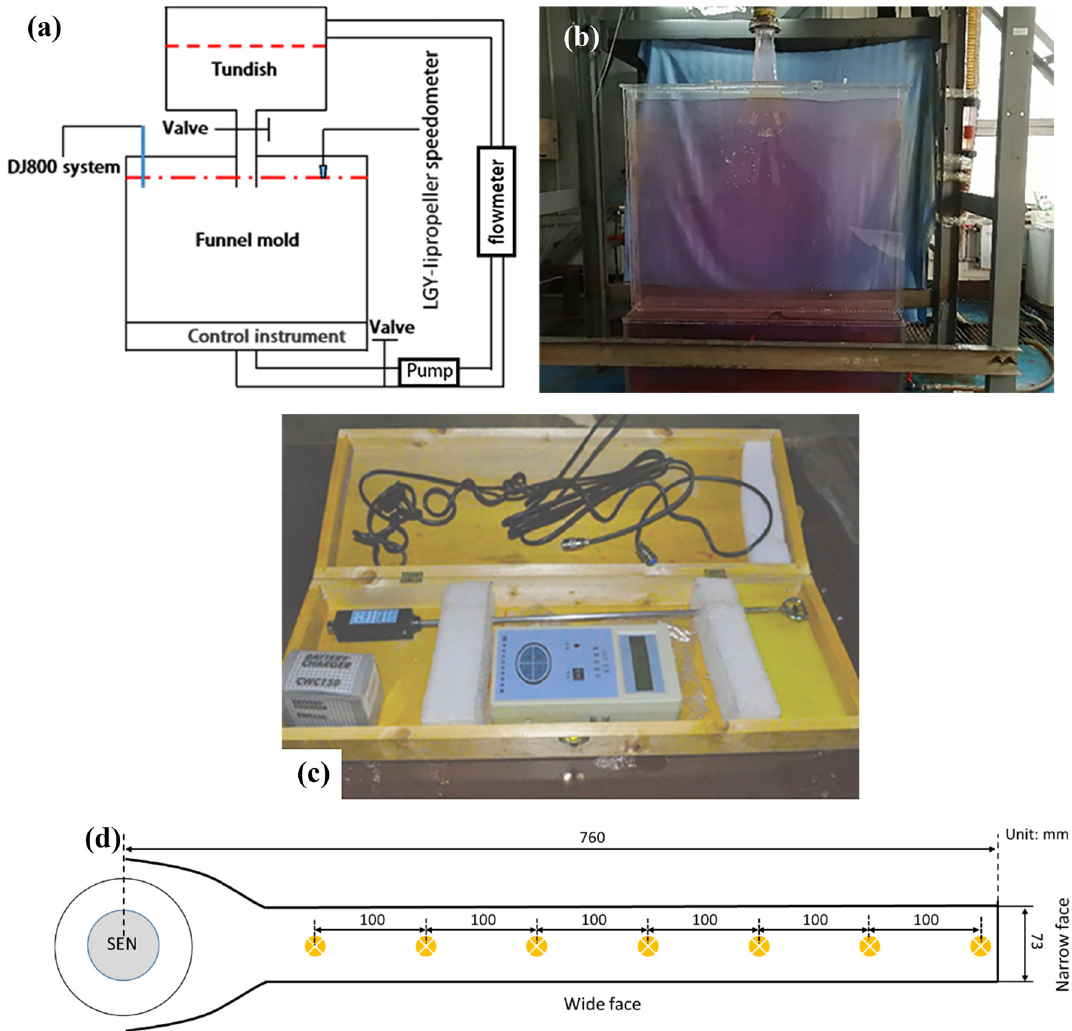
Figure 3: Physical experiment: ( a ) schematic diagram of physical experiment, ( b ) physical experimental model, ( c ) LGY - II propeller speedometer, and ( d ) measuring